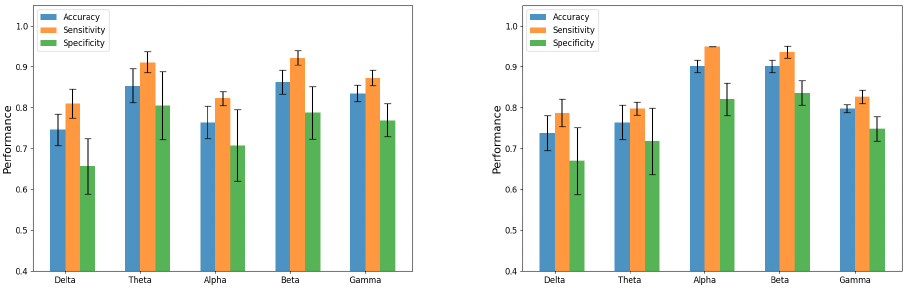
Figure 6. Classification results for 4.8 Hz ( left ) and 16 Hz ( right ).